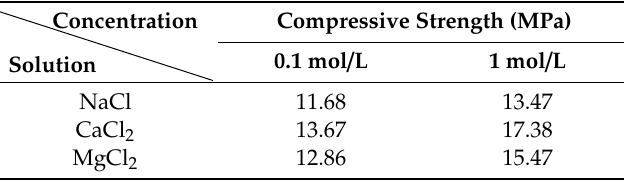
Table 3. Uniaxial compressive strength comparison table.